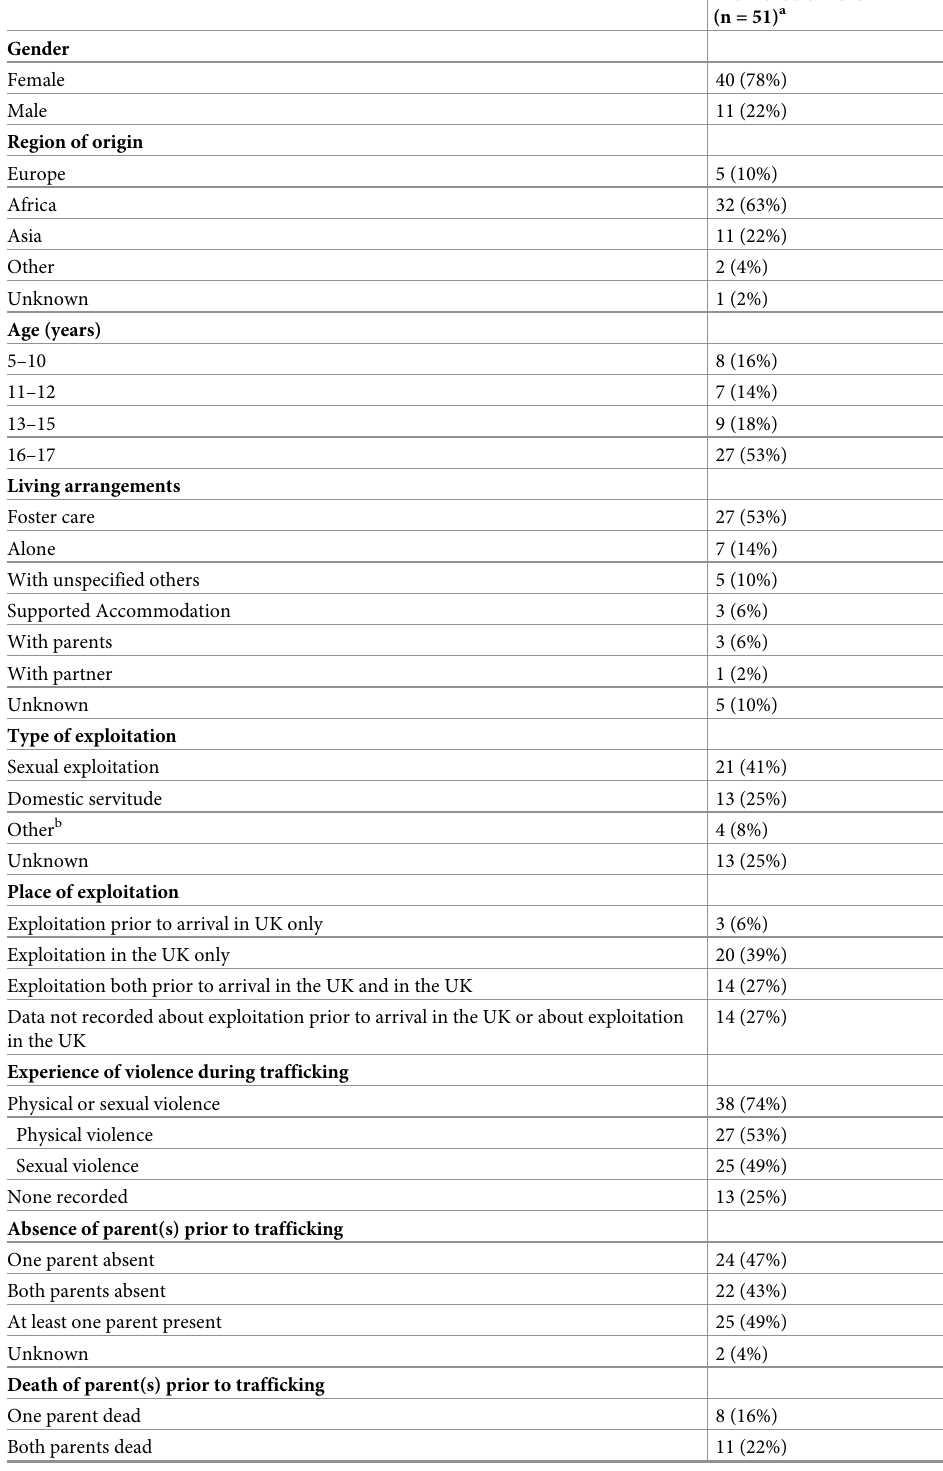
Table 1. Socio-demographic characteristics of and trafficking experiences of trafficked children in contact with secondary mental health